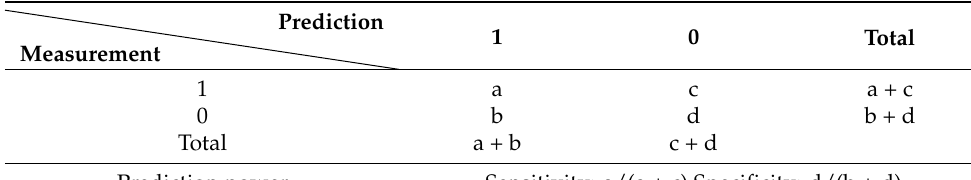
Table 4. Concept of sensitivity and specificity.